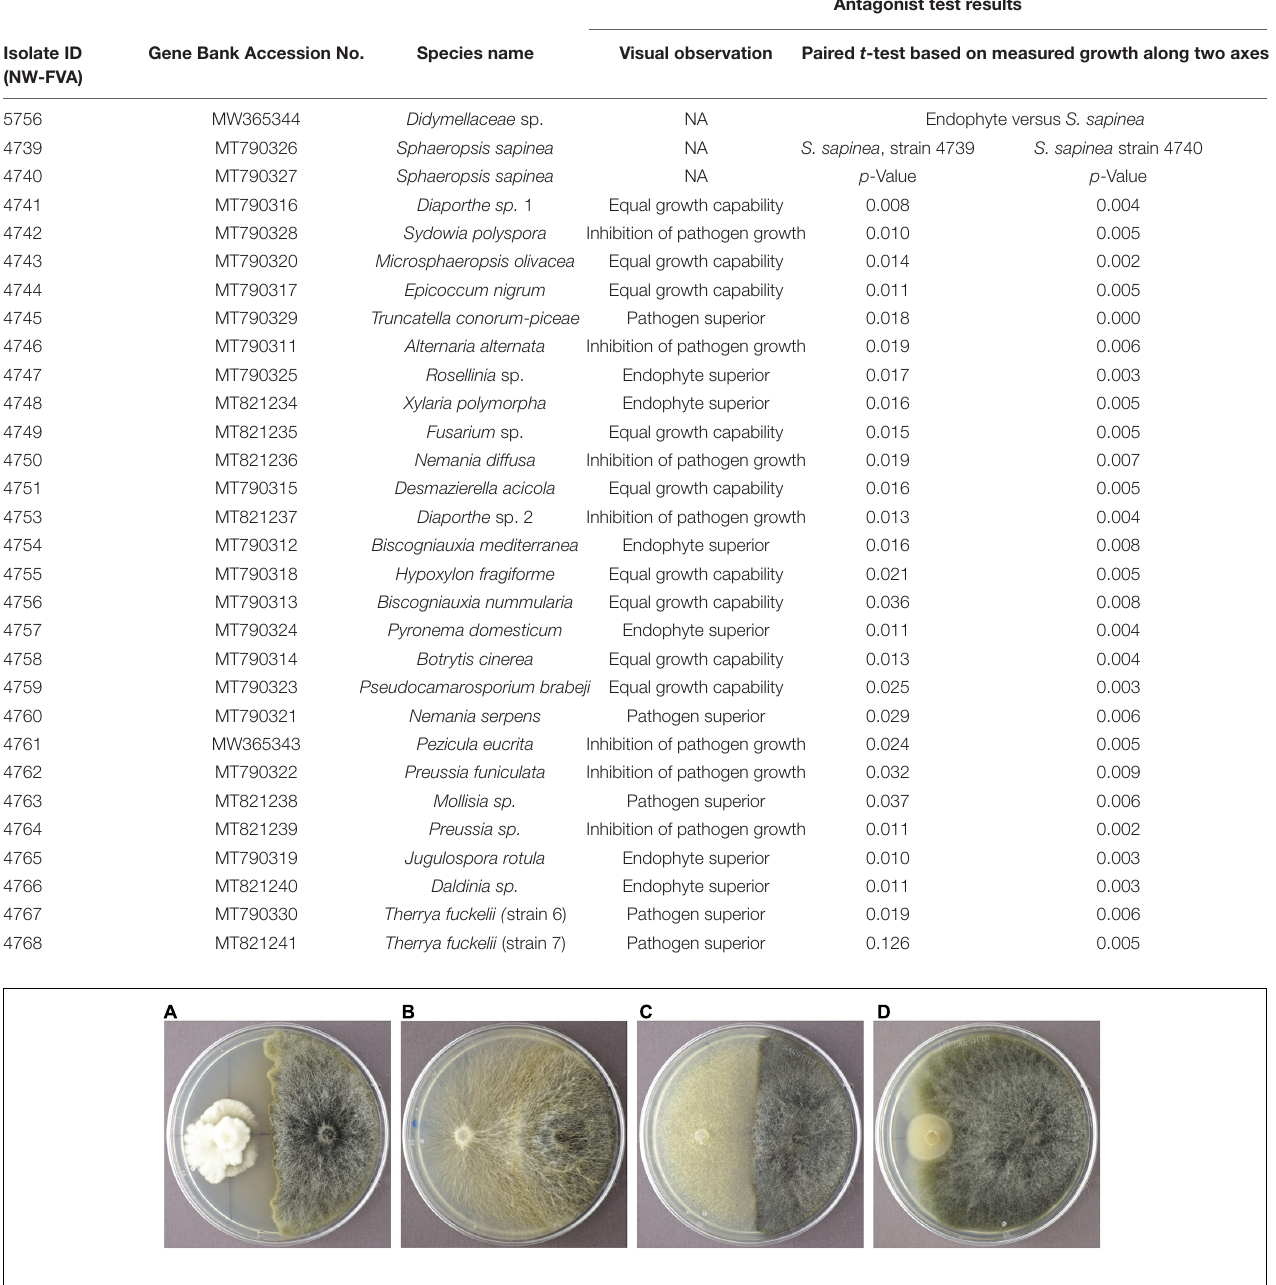
FIGURE 1 | Examples of the different reactions of the endophyte (white mycelium in examples A-D) during the antagonism assays growing in dual culture with S. sapinea (brownish-gray morphology). (A) Nemania diffusa (4750) vs. S. sapinea : inhibition of S. sapinea growth; (B) Biscogniauxia mediterranea (4754) vs. S. sapinea : endophyte superior; (C) Botrytis cinerea (4758) vs. S. sapinea : equal growth; (D) Mollisia sp. (4763) vs. S. sapinea : S. sapinea superior.